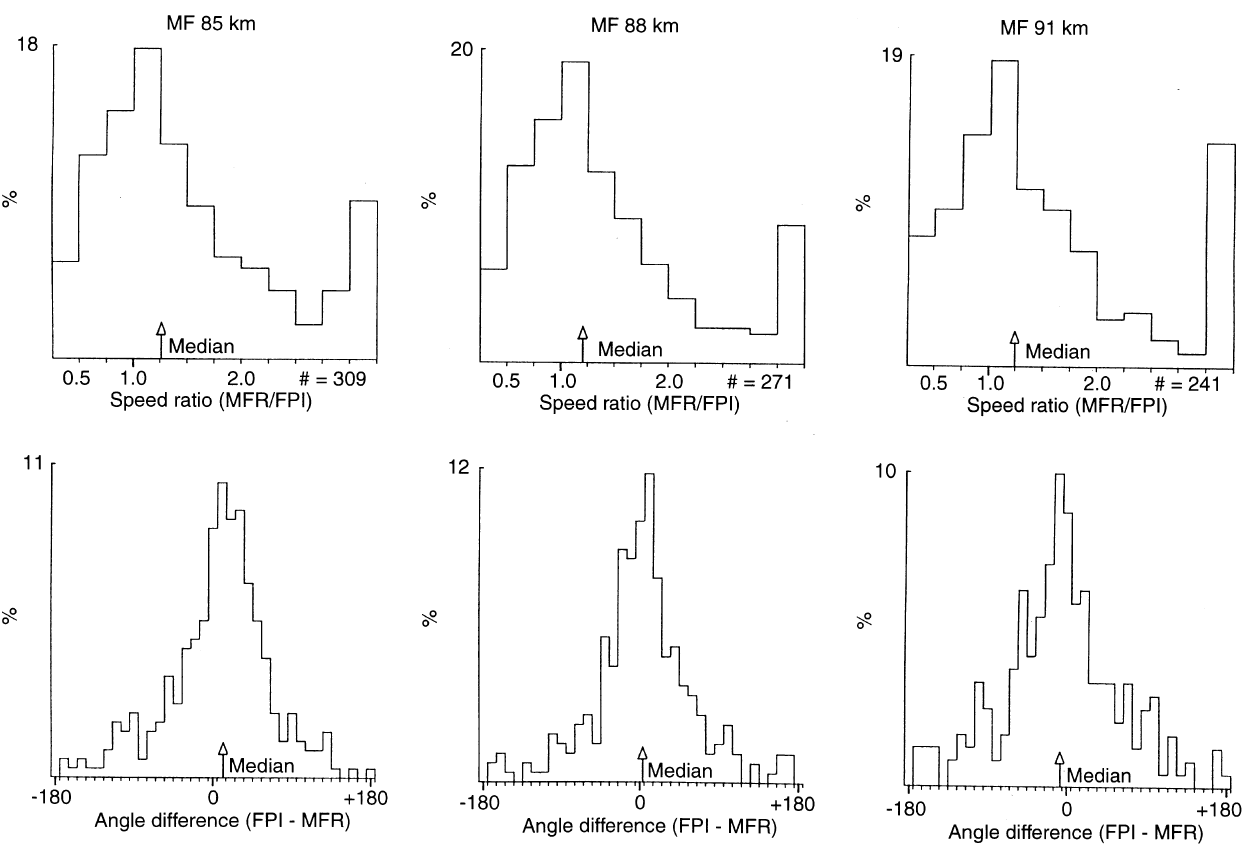
Fig. 2. Calgary FPI (OH line, nominally at 88 km) compared to three heights of Sylvan Lake MFR: 85, 88, and